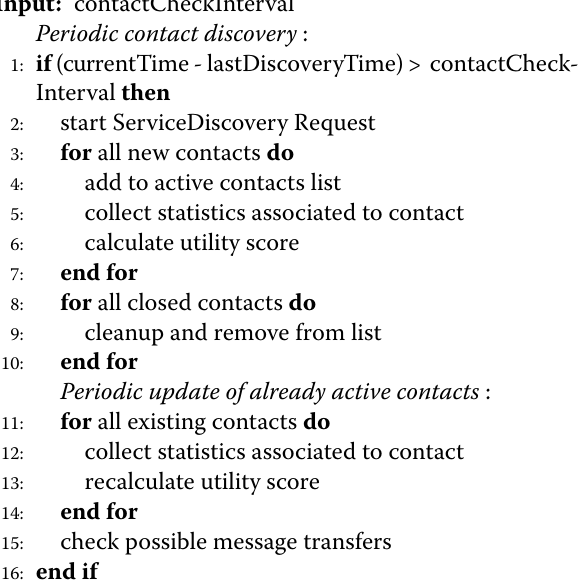
Algorithm 1 General idea for contact-aware scoring func-